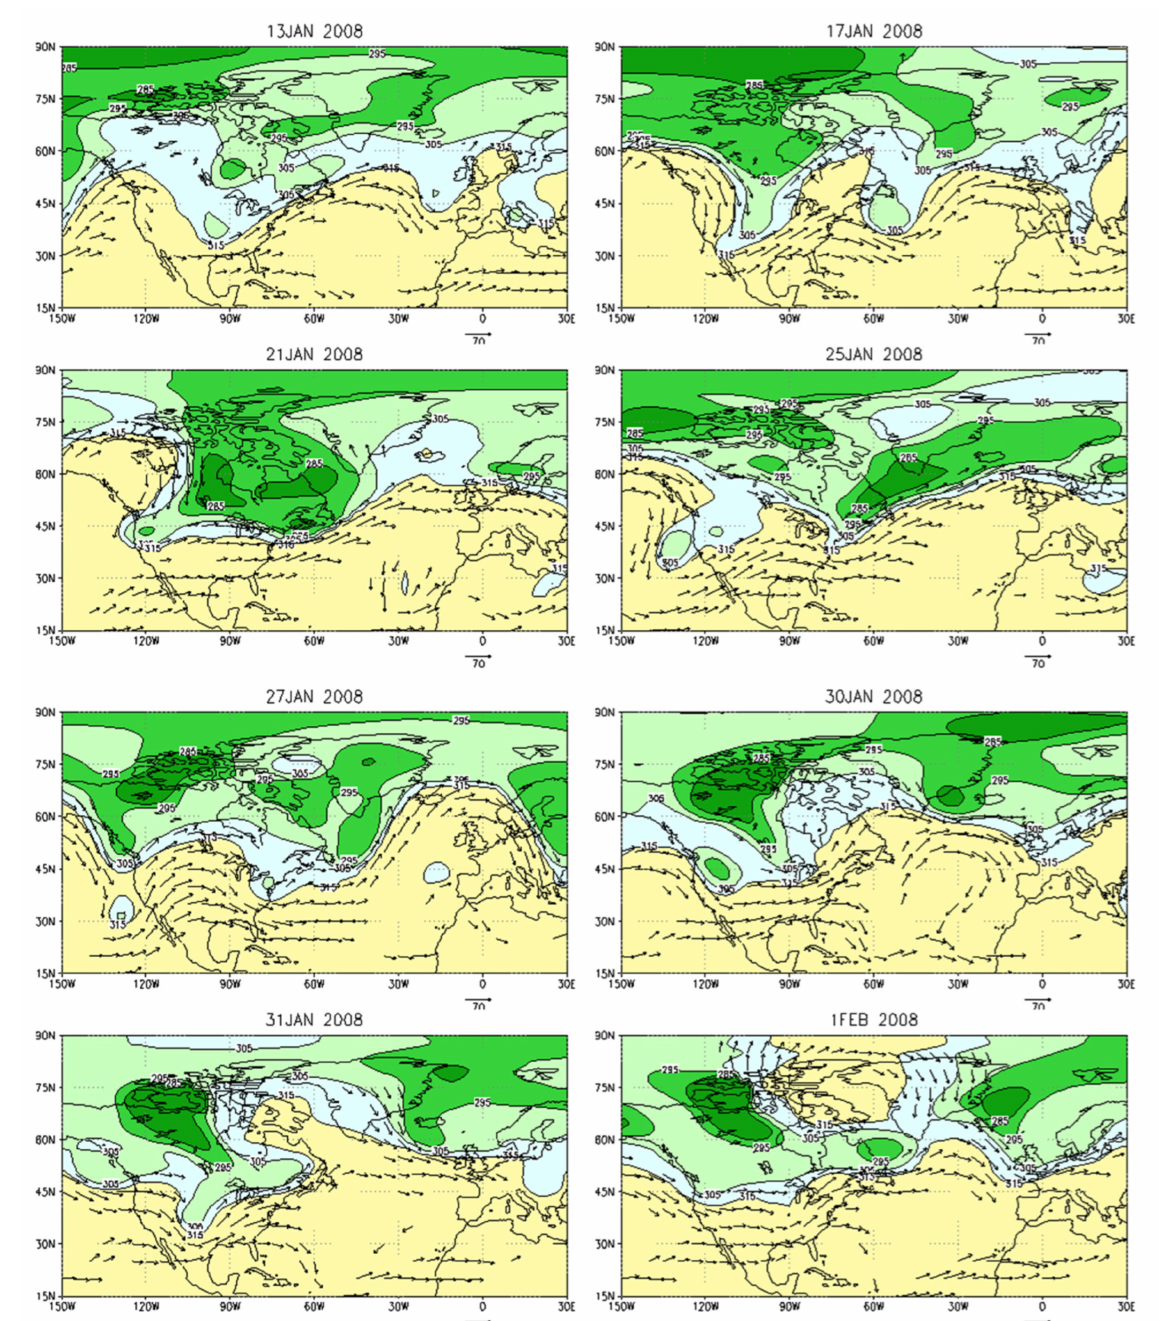
Figure 3. Unfiltered θ wind fields on the 2-PVU surface for the positive AO/NAM event from 14 January to 3 February 2008 ( θ , shaded, unit: K; the wind, vectors, unit: ms − 1 ; the corresponding date is marked on the top of each